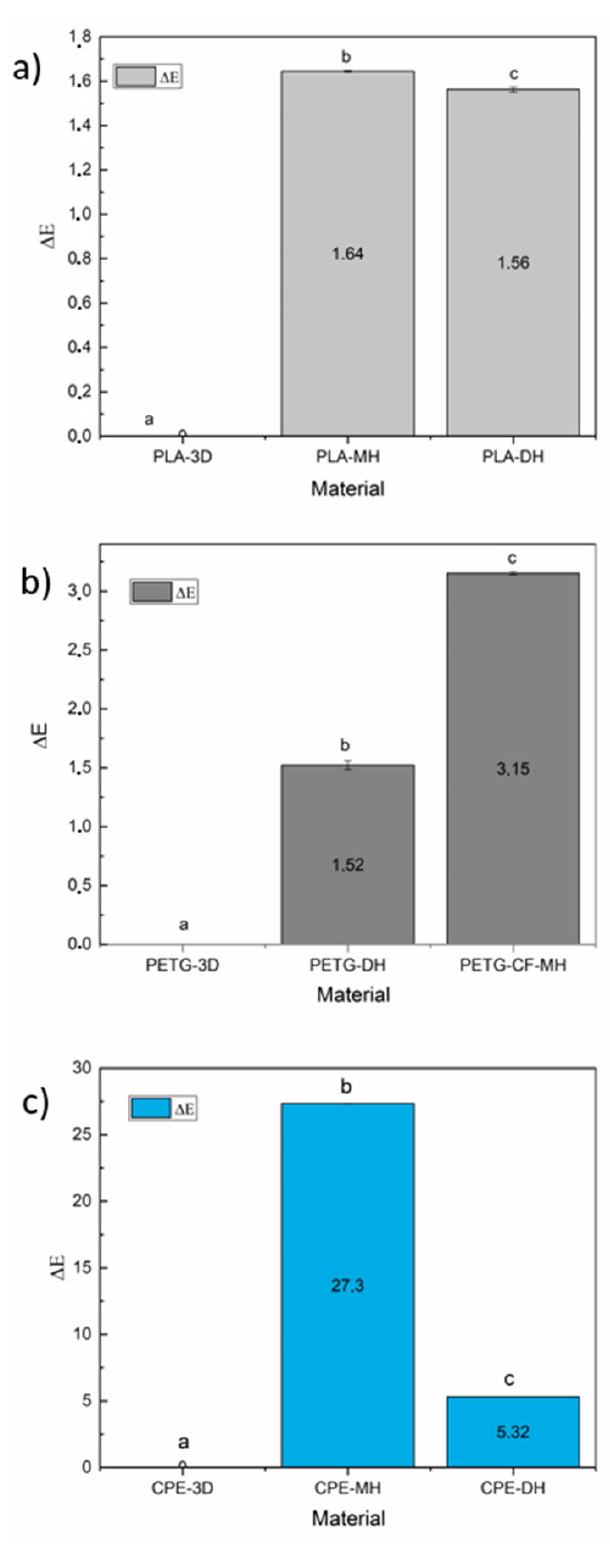
Figure 13. Total color differences before and after the sterilization of the 3D printed samples of ( a ) PLA, ( b ) PETG+CF, and ( c ) CPE-based samples. a–c Different letters show statistically significant differences between formulations ( p < 0.05).